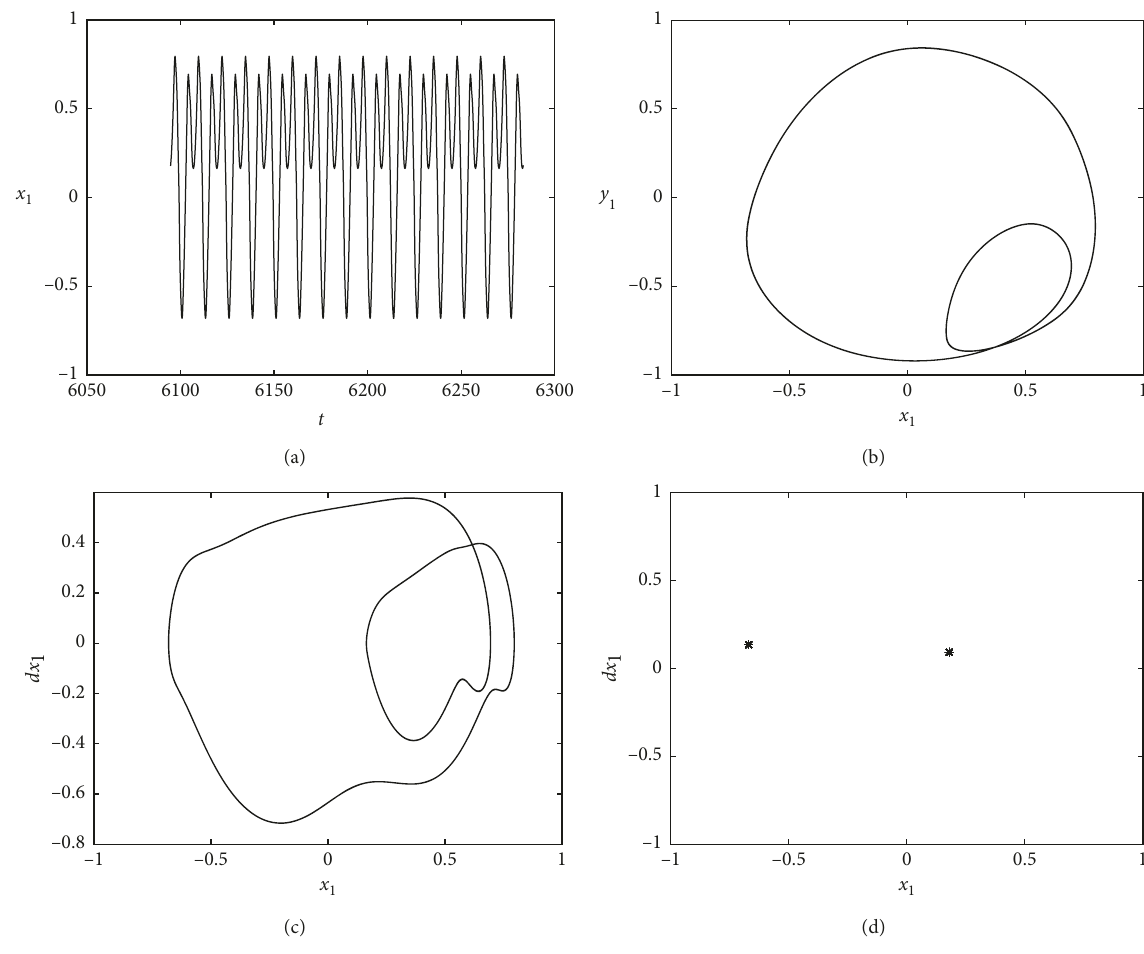
Figure 3: Response of the rotor system when ω � 600rad/s.